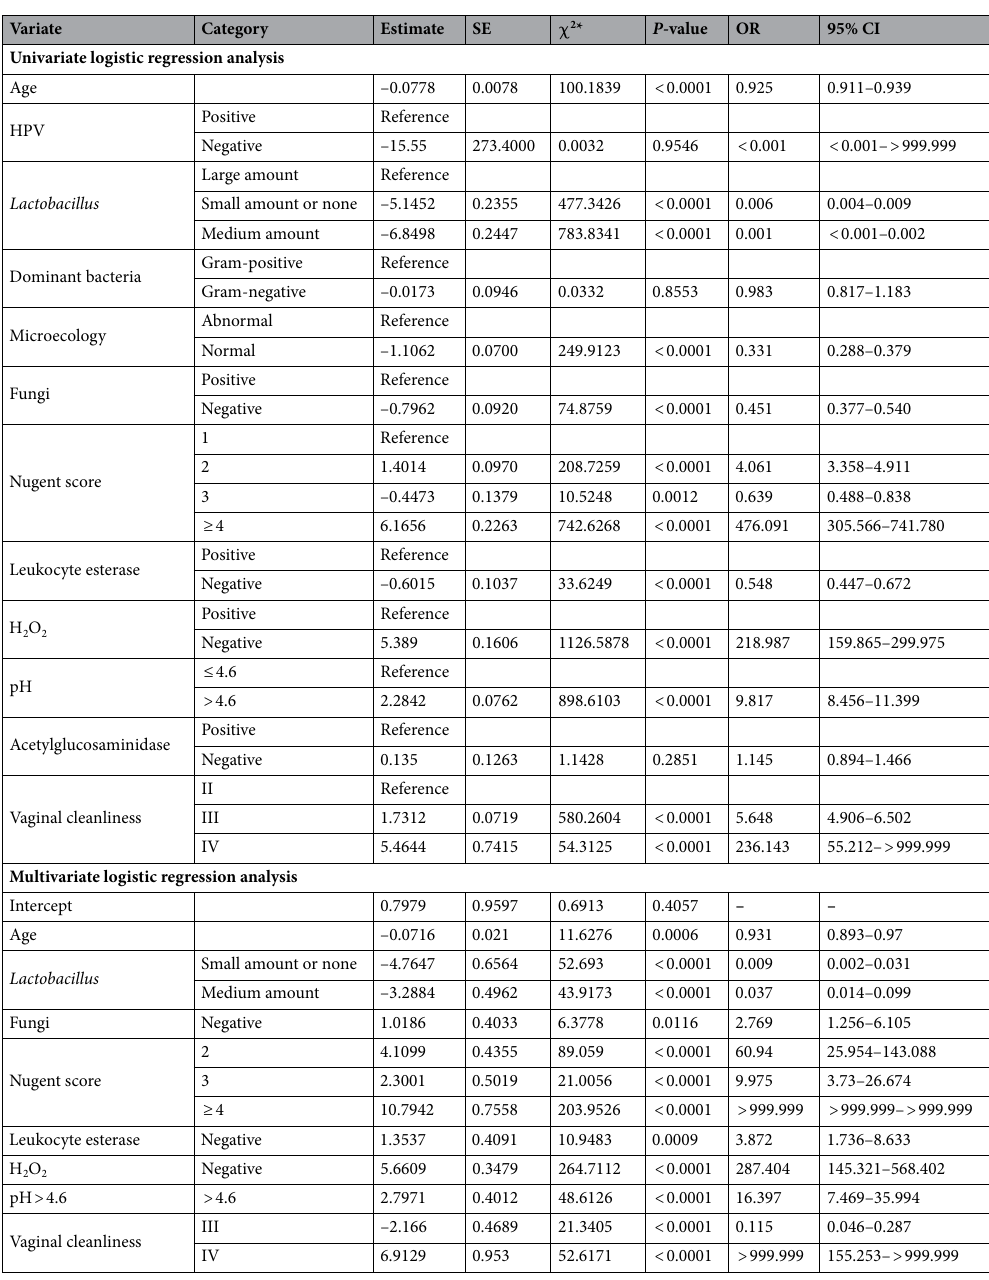
Table 2. Univariate and multivariate logistic regression results of IUA group and non-IUA group. CI confidence interval, HPV human papillomavirus, IUA intrauterine adhesion, OR odds ratio. *Chi-squared test for the entire